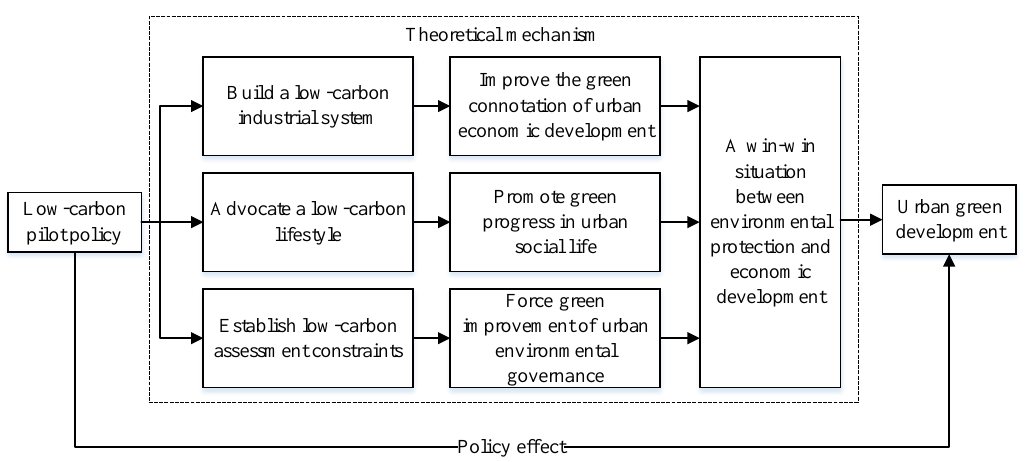
Figure 2. Theoretical mechanism for low-carbon pilot policies to promote green